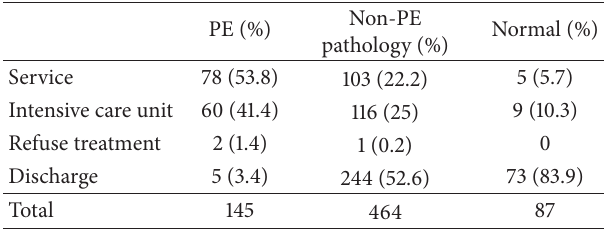
Table 6: Final decision—CT